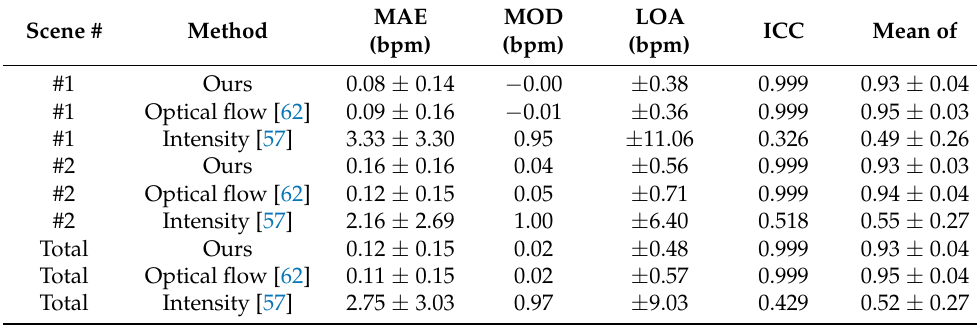
Table 4. Respiration measurements in motion-controlled environments.